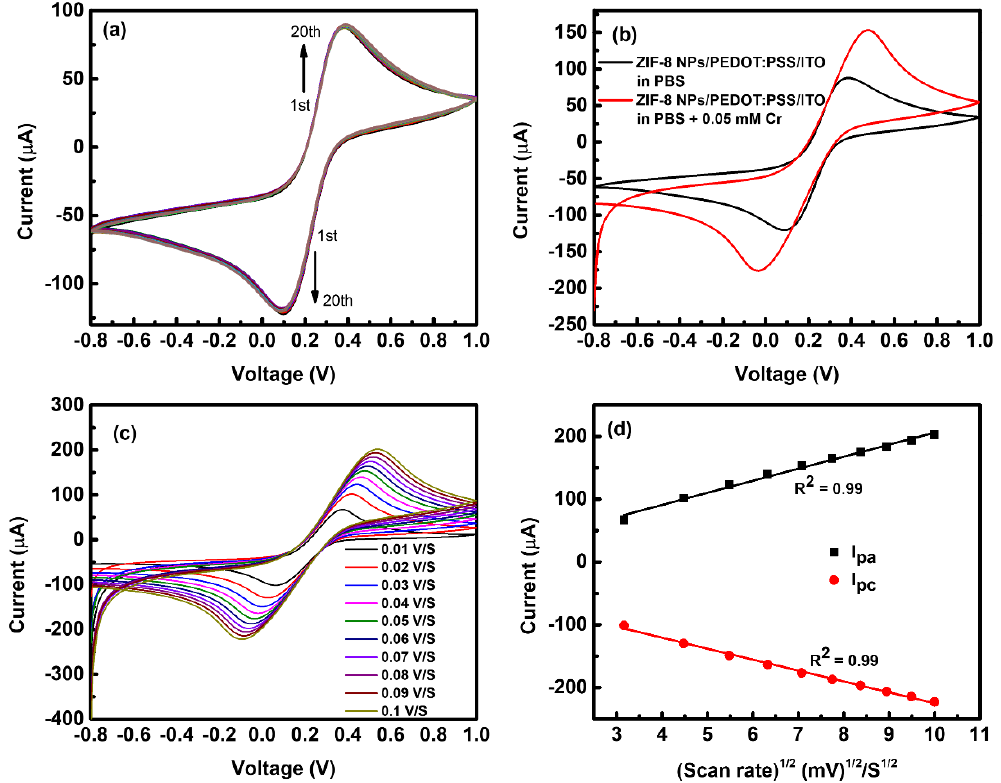
Figure 6. ( a ) CV for 20 cycles of ZIF-8 NPs/PEDOT:PSS/ITO electrode in PBS 7.4 containing 1 mM [Fe(CN) 6 ] 3 − /4 − and 0.1 M KCl at a scan rate of 50 mV/S ( b ) comparison of CV curves for ZIF-8 NPs/PE- DOT:PSS/ITO electrode in PBS 7.4 containing 1 mM [Fe(CN) 6 ] 3 − /4 − and 0.1 M KCl with and without 0.05 mM of creatinine ( c ) CV of ZIF-8 NPs/PEDOT:PSS/ITO electrode for different scan rates (10 mV/S to 100 mV/S) in PBS 7.4 containing 1 mM [Fe(CN) 6 ] 3 − /4 − and 0.1 M KCl containing 0.05 mM of creatinine ( d ) The plot of redox peak currents I pa and I pc vs. square roots of the scan rates.